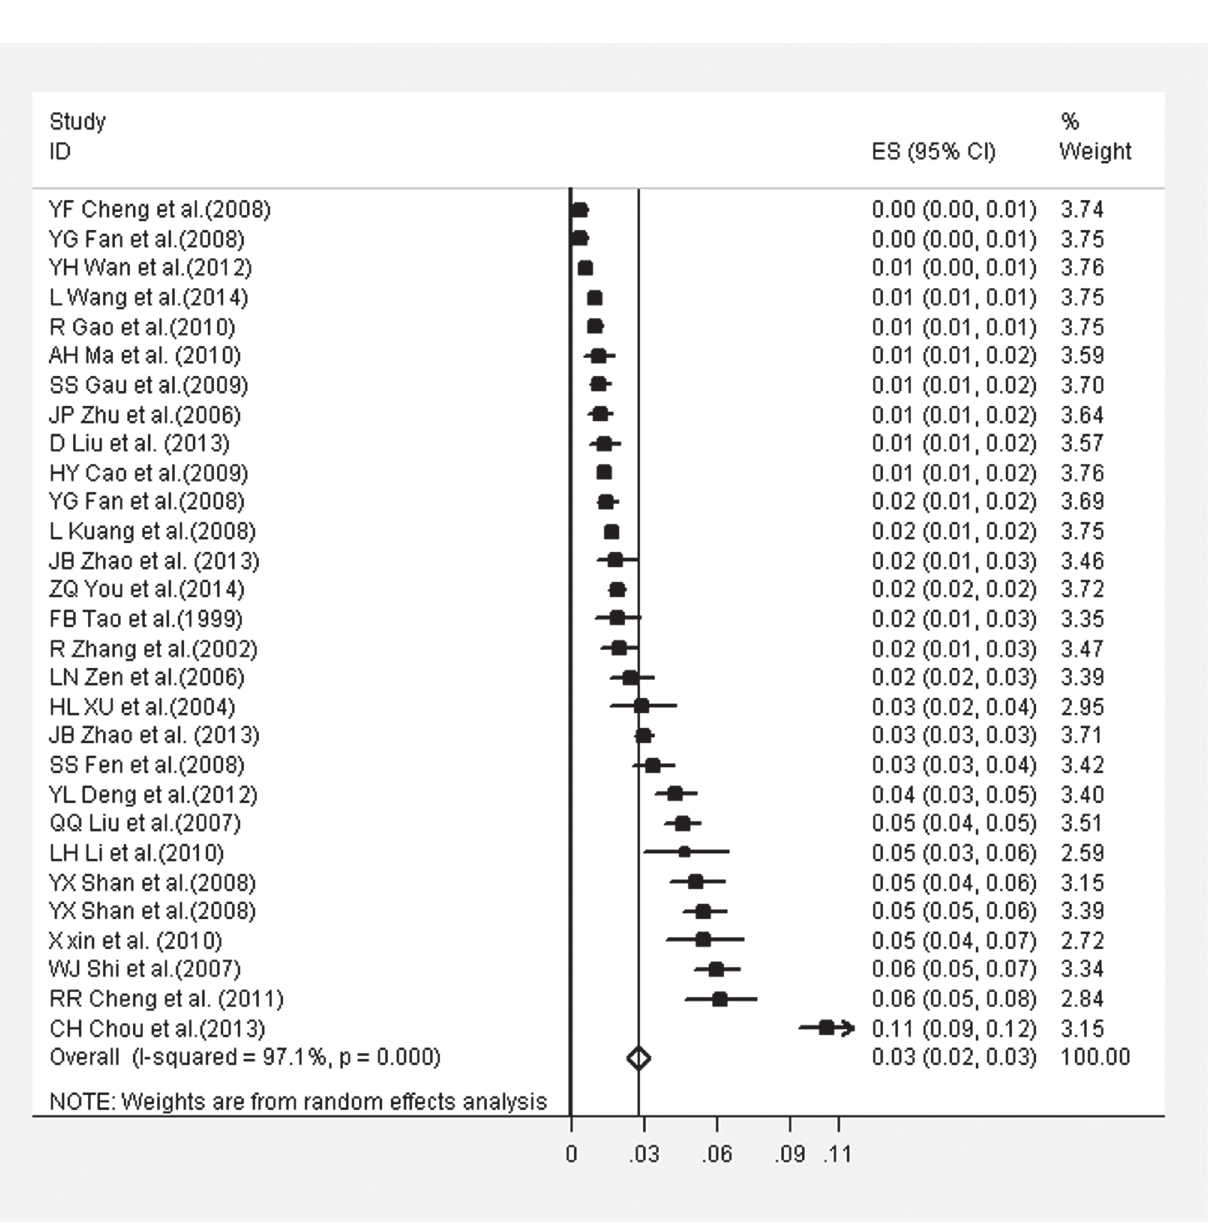
Figure 2. Forest plot of the 29 studies included in the